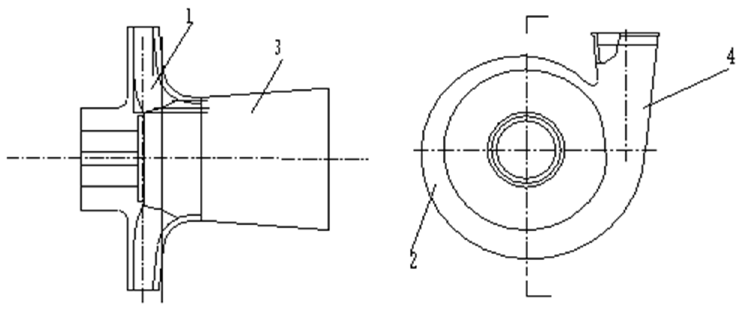
Figure 1. Schematic diagram of centrifugal pump. 1—Impeller; 2—Water pressure chamber; 3—Suction chamber; 4—Diffuser.